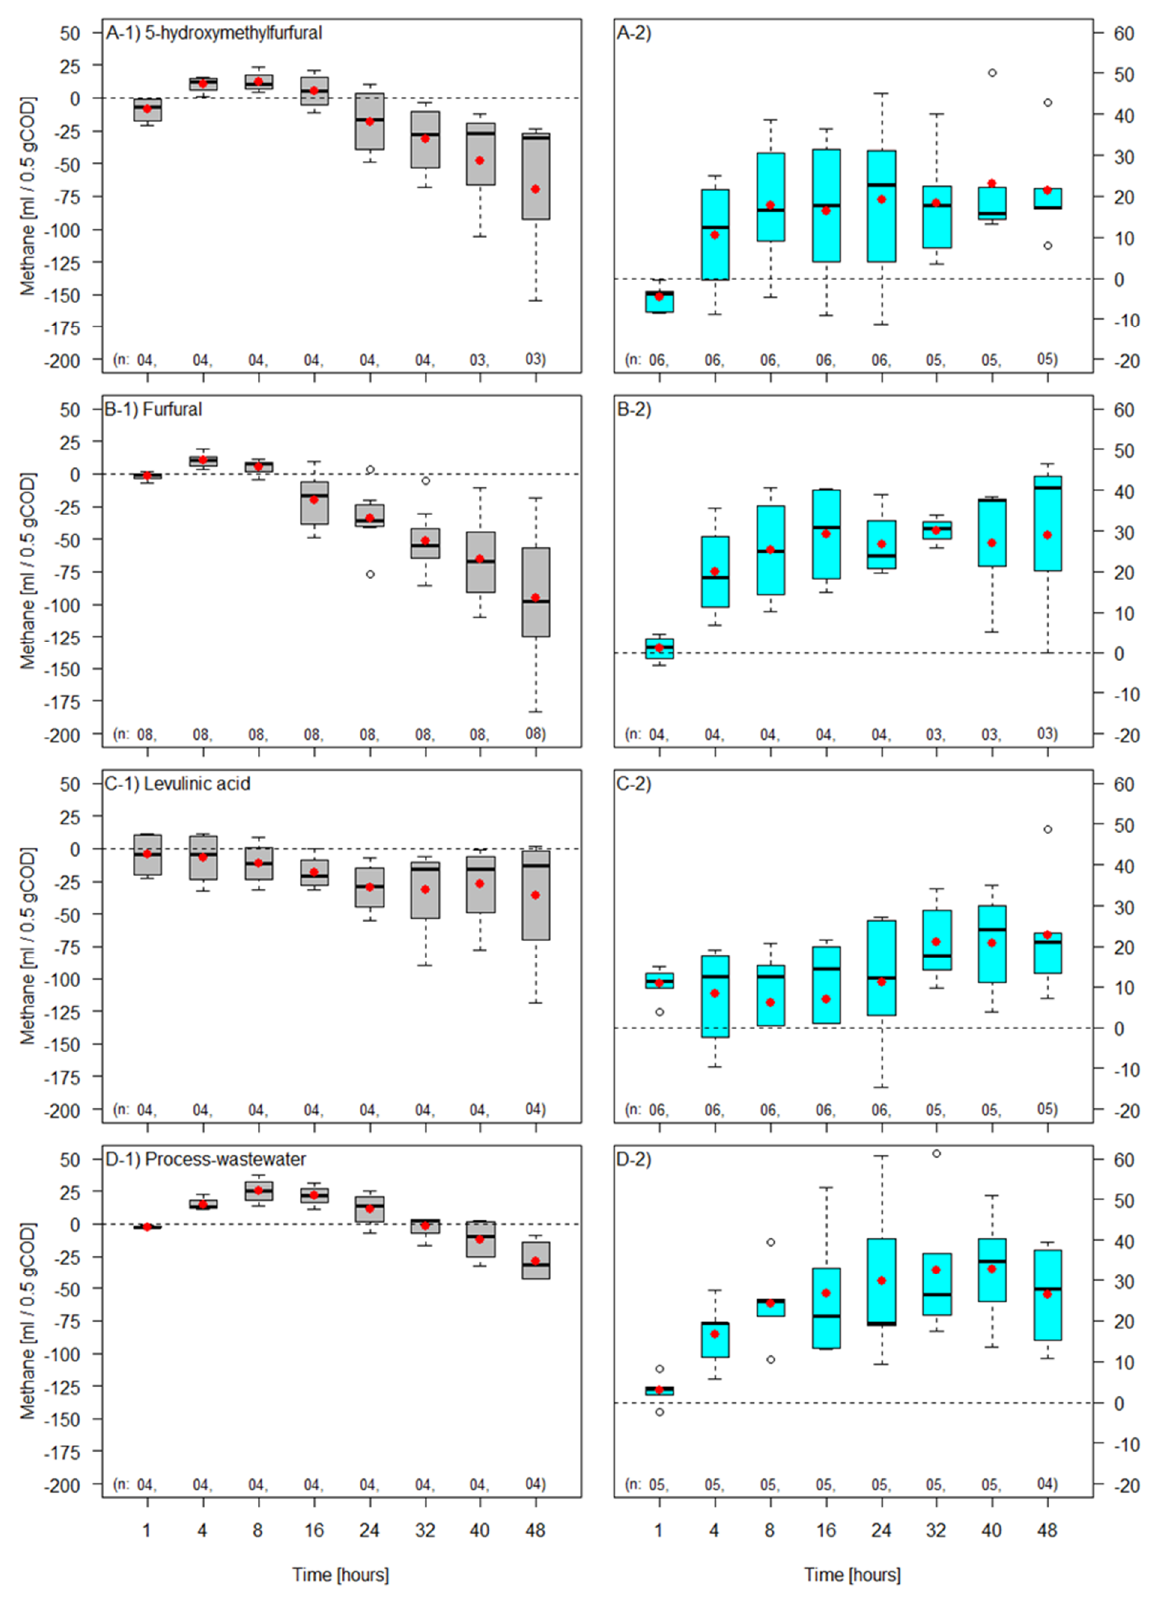
Figure 4. Inhibitory ( left ) and retarded degradation ( right ) for ( A ) 5-hydroxymethylfurfural, ( B ) furfural, ( C ) levulinic acid, and ( D ) process-wastewater in the anaerobic filters after its administration. The box plot is characterized by the minimum, 25% quartile, mean, median, 75% quartile, and maximum value.